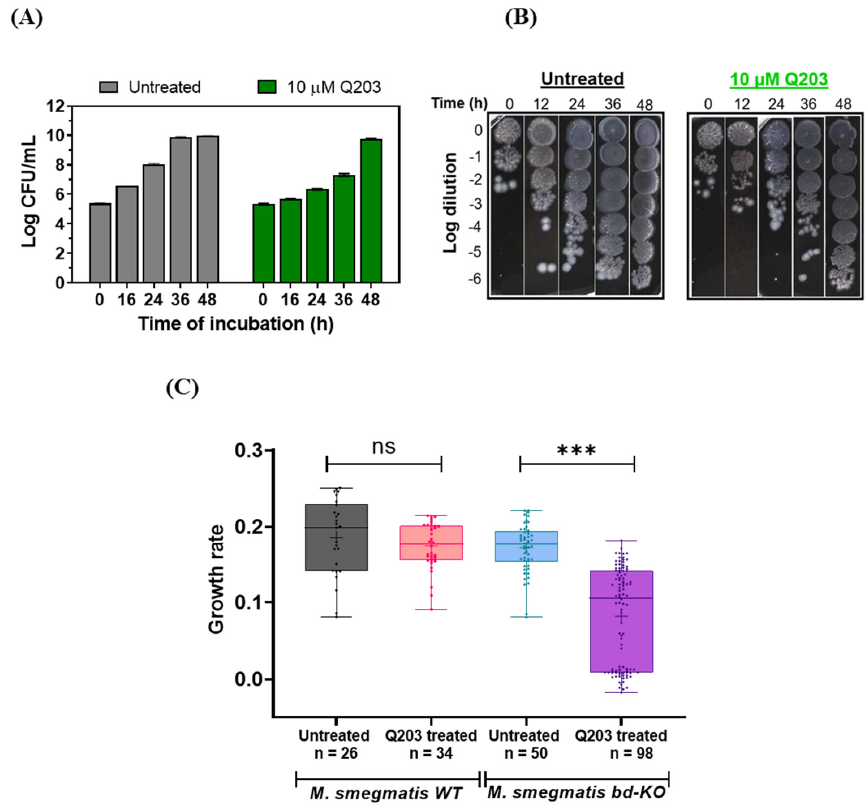
Figure 3. Analysis of variation in adaptability of Mycobacterium smegmatis cells to Q203. ( A ) Quanti ‐ fication of surviving M. smegmatis bd ‐ KO after exposure to Q203 in 7H9 complete medium for the indicated time. Colony forming units (CFU/mL) were subsequently counted on agar plates after three days of incubation at 37 °C. Data are Mean ± SD from two independent experiments (biological replicates), each comprising three technical replicates. ( B ) Representative dilution series of M. smeg ‐ matis bd ‐ KO after exposure to Q203 in 7H9 complete medium for the indicated time. Each spot rep ‐ resents a 5 μ L aliquot. ( C ) The growth rate of individual M. smegmatis WT and bd ‐ KO cells was determined using time ‐ lapse microscopy. Cells were imaged for 40 h in 30 min intervals using aga ‐ rose ‐ pads which were either prepared using 2.5 μ M Q203 (treated) or DMSO solvent control (un ‐ treated). The determined growth rates of individual cells are indicated by dots in a box ‐ whisker plot. p values were calculated by t test in Anova, *** represent p < 0.001, ns = non ‐ significant.